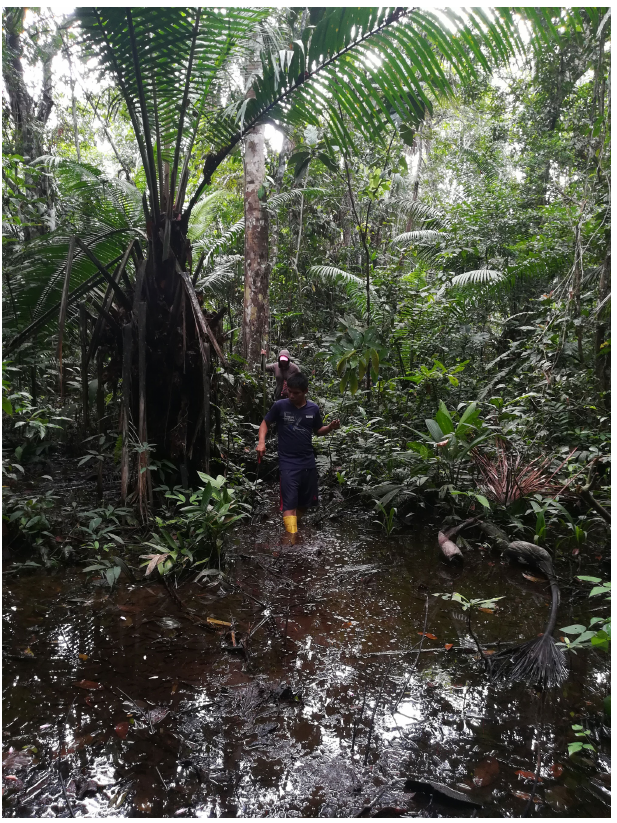
Fig. 2 . A jiiri ; this ecosystem consists of “open space” with short vegetation and very soft, waterlogged ground, but note that the jiiri ecosystem may have very diverse appearances.